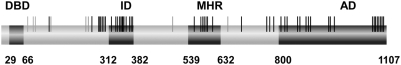
Localisation of 65 non-synonymous substitutions in CgPdr1p.The eight polymorphisms present in CgPDR1 alleles from both azole-susceptible and azole-resistant isolates are indicated by grey bars. The 57 amino acid polymorphisms (from a total of 58 mutations) specific for CgPDR1 alleles from azole-resistant isolates are indicated by black bars. Putative DBD (DNA binding domain) and MHR (middle homology region) were located by Pfam analysis. ID (putative inhibitory domain) and AD (putative transcriptional activation domain) were deduced by similarity with Pdr1p and Pdr3p from S. cerevisiae
[11]. The limits of these domains are indicated by amino acids position in CgPdr1p.